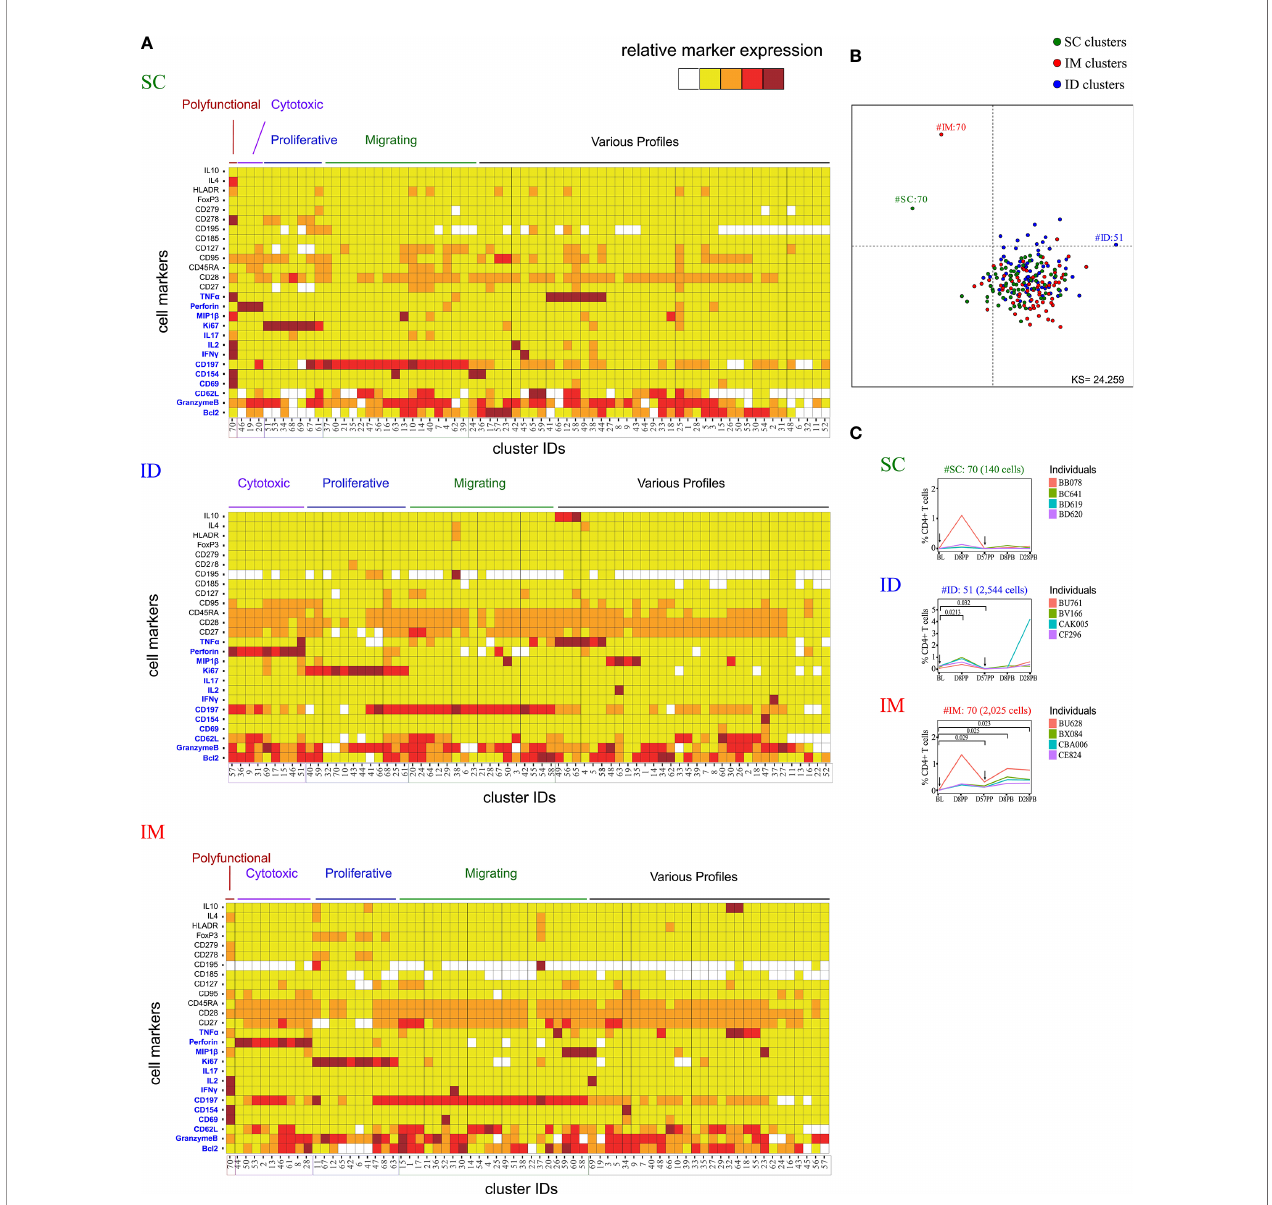
FIGURE 3 | Characterization of the impact of the SC/ID/IM routes on CD4 + T-cell cluster diversity by mass cytometry. (A) Categorical marker expression heatmap representing the phenotypes of CD4 + T cells for each administration route. SPADE analysis was performed for each administration route based on the entire cell set according to the gating strategy described in Figure S1 . Markers in blue were used as clustering markers in the SPADE analyses. Cell clusters were organized into families by hierarchical clustering. The fi ve-tiered color scale, from white to deep red, represents relative marker expression. (B) Two-dimensional MDS representation showing the phenotypic differences and similarities between cell clusters identi fi ed by each SPADE analysis. Phenotypic similarities were quanti fi ed based on the MSI of the 13 SPADE clustering markers (C) Charts showing changes in the percentage of CD4 + T cells over time for the selected marginal clusters. Black arrows indicate the days of vaccine injection. BL, baseline; D, day; PP, post-prime; PB,